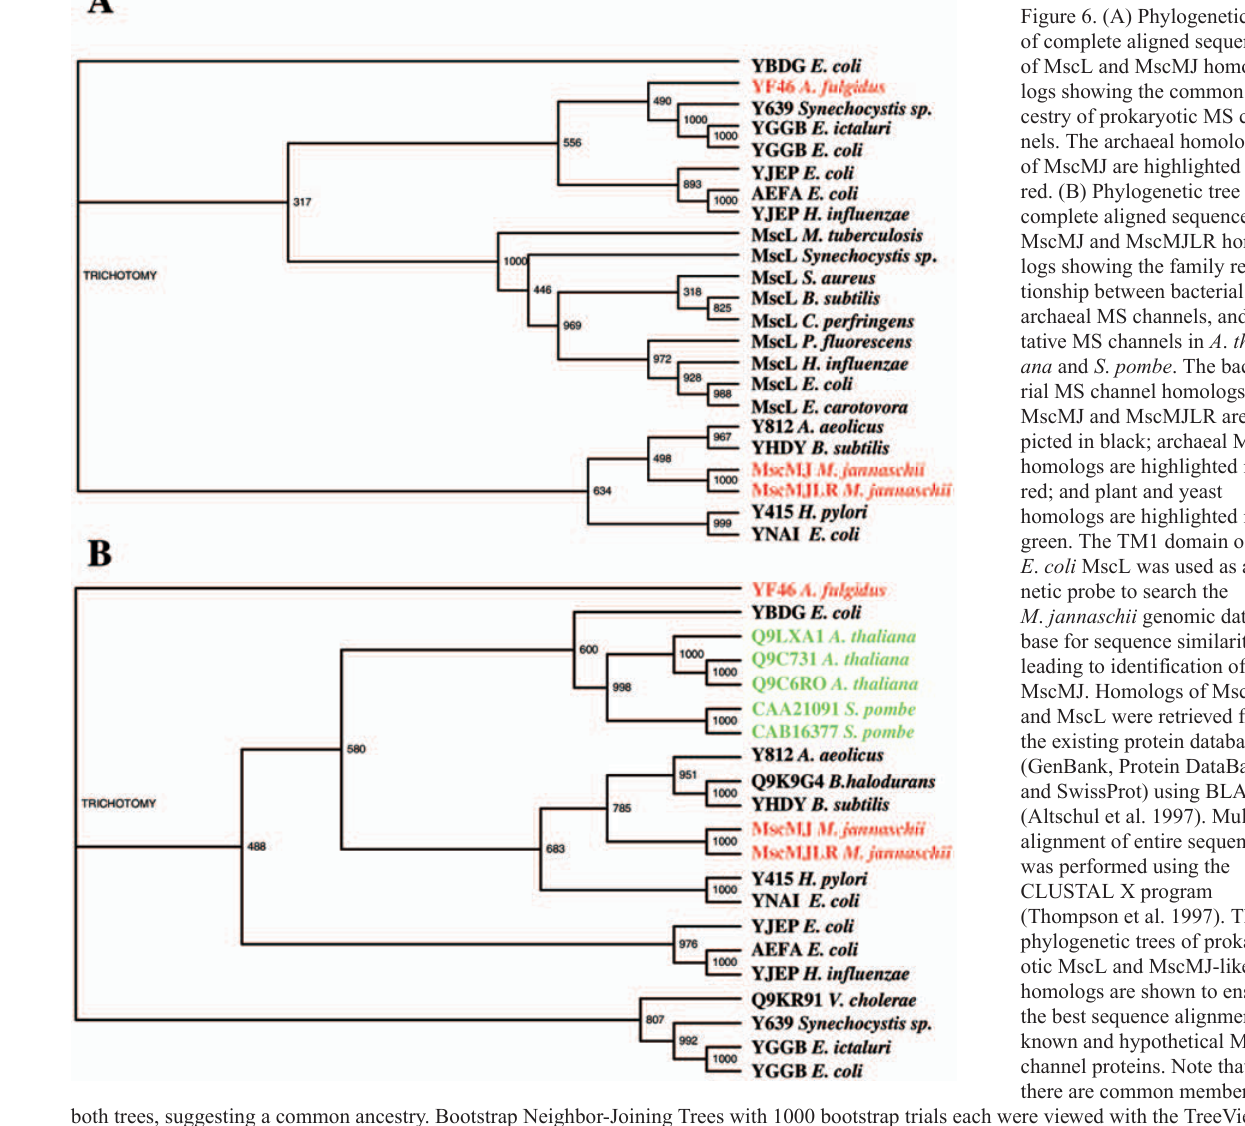
(Hamill and Martinac 2001). The presence of multiple MS channels in microbial cells indicates that they may be neces- sary for survival in environments with frequent osmotic chal- lenges.